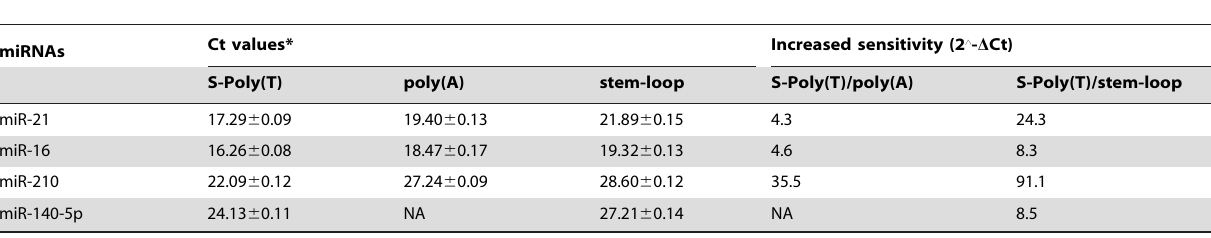
Table 1. The Ct values of miRNA qPCR assays using three different methods.